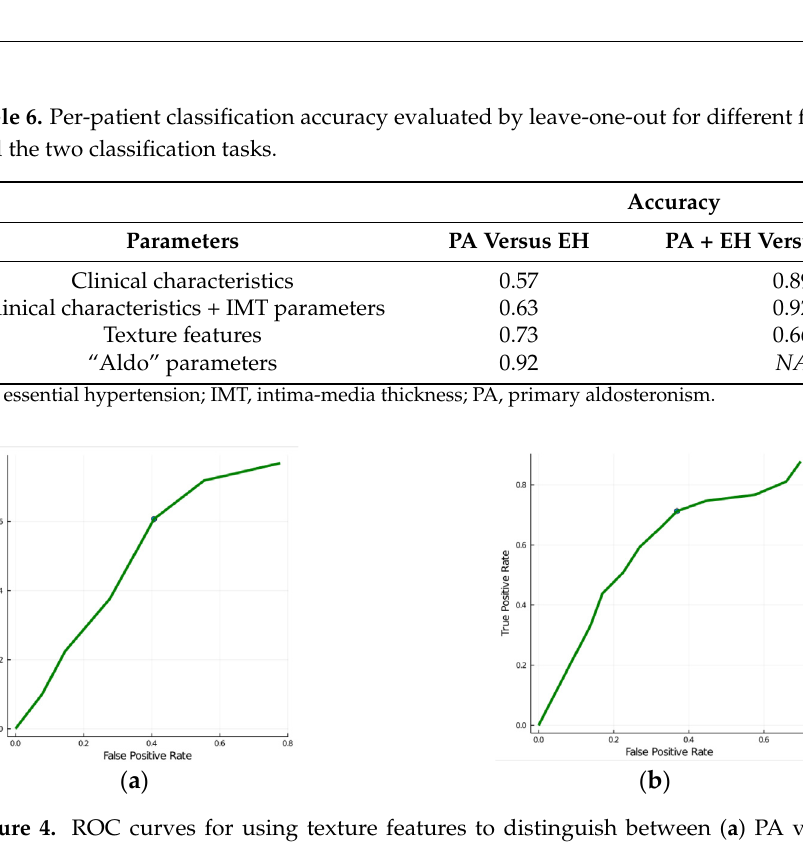
Table 6. Per-patient classification accuracy evaluated by leave-one-out for different feature subsets and the two classification tasks .